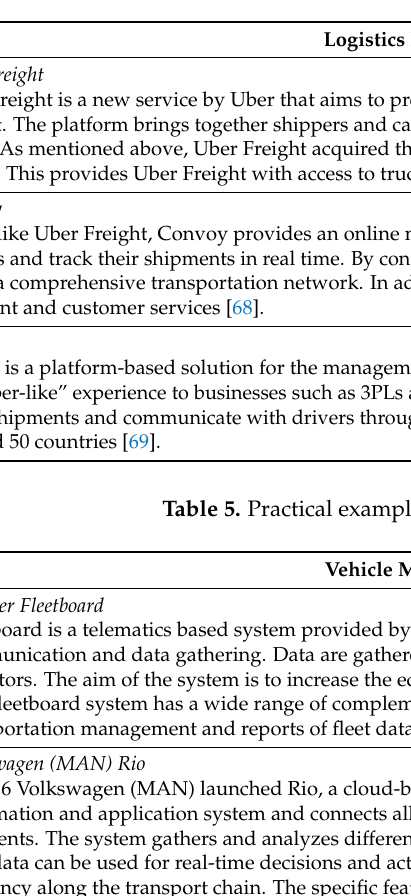
Table 4. Practical examples of logistics marketplace platforms.